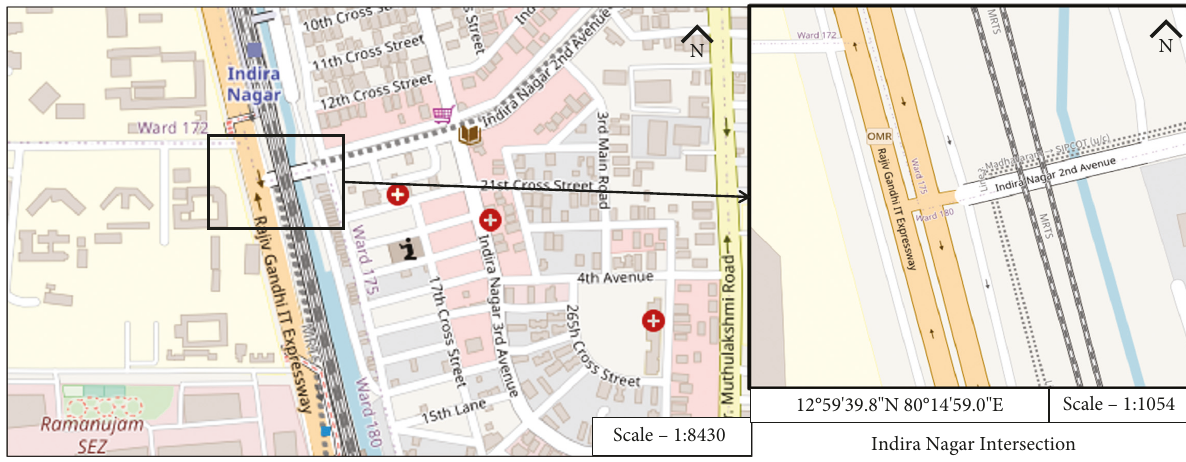
Figure 1: Location of the study Table 2: Traffic demand and signal timings (from the field).